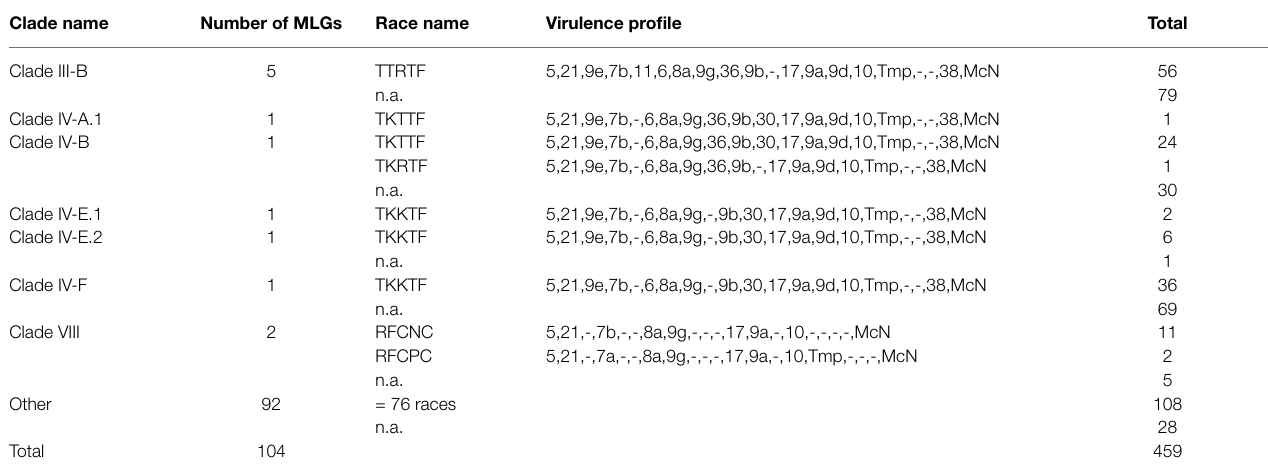
TABLE 3 | Races detected in Europe within previously defined genetic groups (clades) and number of MLGs in